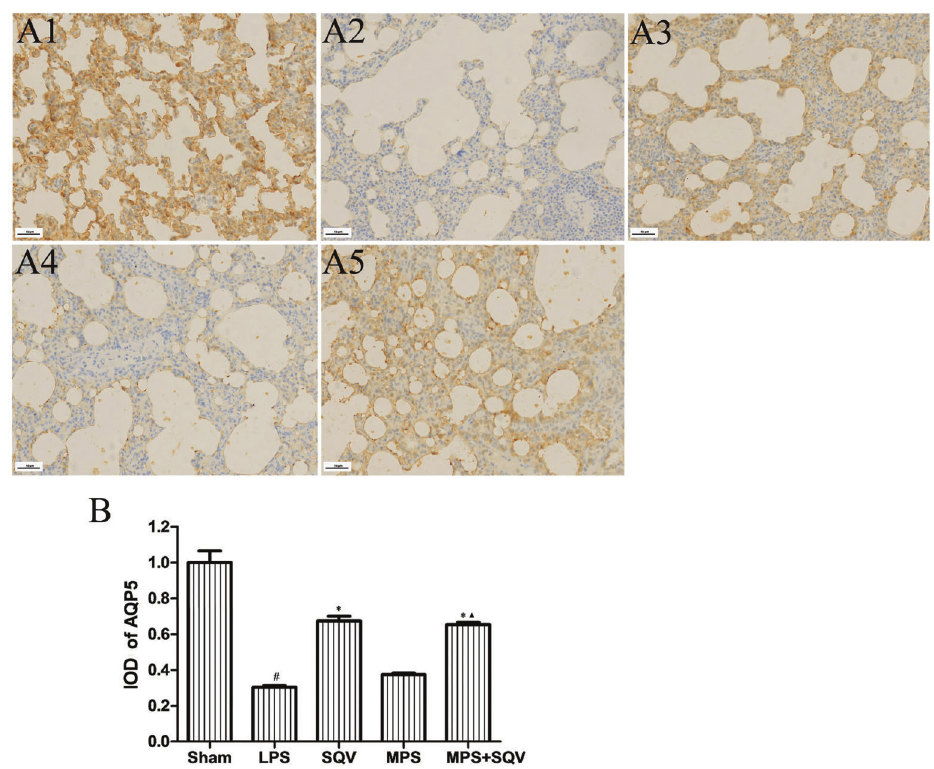
Figure 6. In fl uence of saquinavir (SQV) plus methylprednisolone (MPS) on the expression of aquaporin 5 (AQP 5) in acute lung injury (ALI) model. Immunohistochemistry of AQP 5 for sham ( A1 ), lipopolysaccharide (LPS) ( A2 ), SQV ( A3 ), MPS ( A4 ), and MPS plus SQV ( A5 ). Scale bar = 50 m m. B , Effects of SQV on the integral optical density of AQP 5 in the two-hit ALI rats (n=5). Data are reported as means ± SD. # P o 0.01 vs the sham group; *P o 0.01 vs the LPS-treated rats. m P o 0.01 vs MPS group (Dunnett ’ s